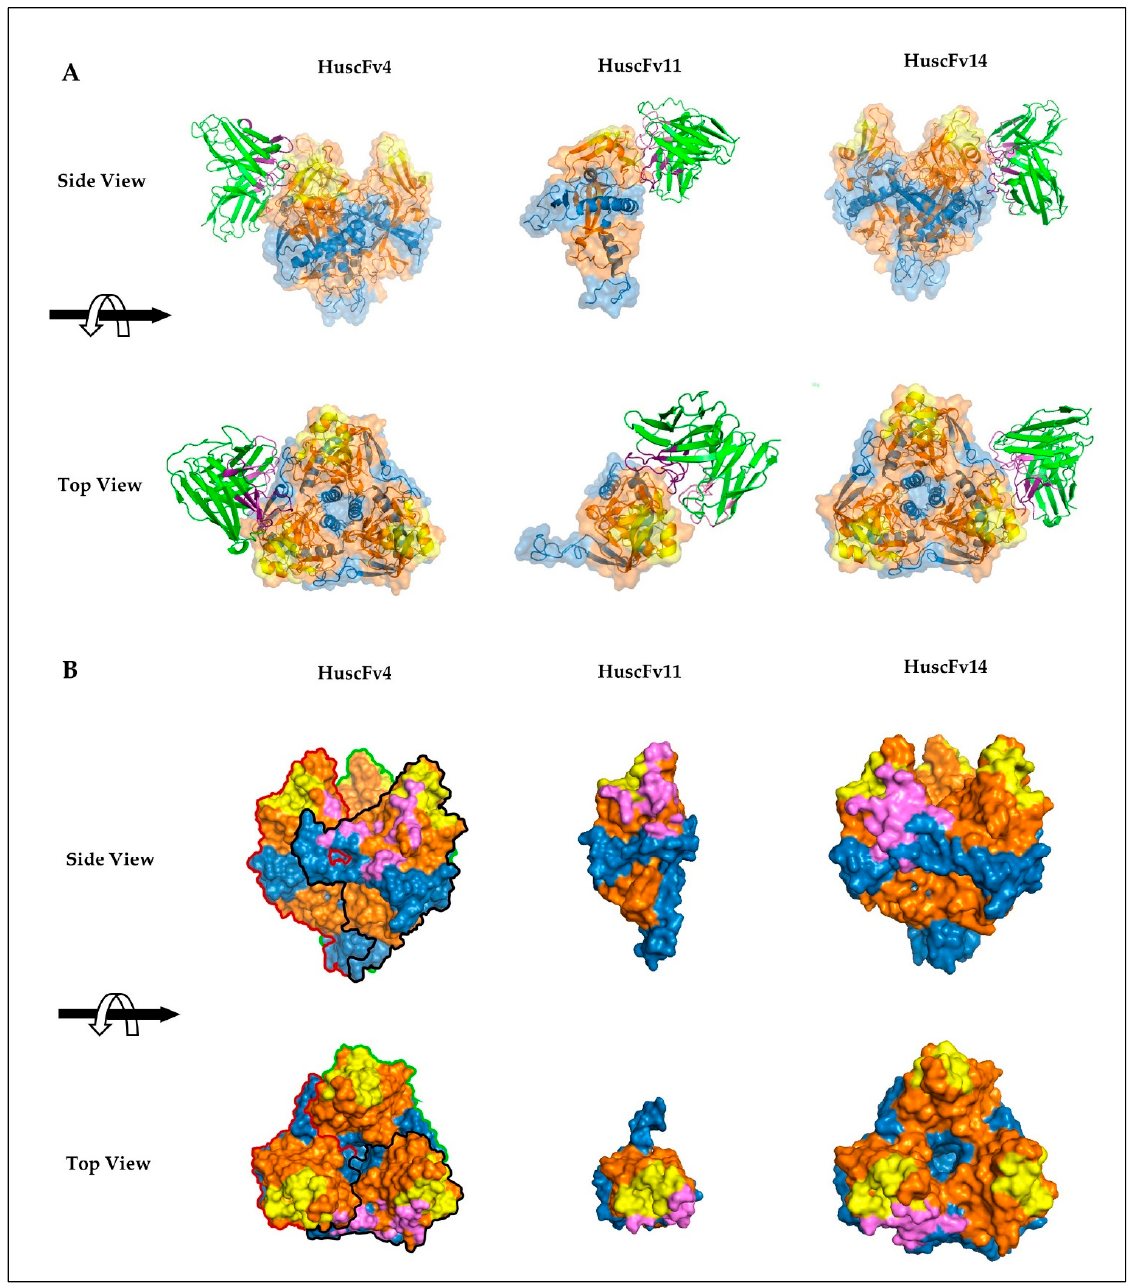
Figure 5. Presumptive binding of HuscFvs to GPcl predicted by computerized homology modeling and intermolecular docking. ( A ) Interactions of HuscFv4 and HuscFv14 to trimeric GPcl (PDB: 5F1B) (left and right panels, respectively) and HuscFv11 to monomeric GPcl (PDB: 5HJ3) (middle panel). The HuscFv-GPcl complexes are shown as the side view (upper panel) or top view (lower panel). The HuscFvs are colored in green, in which CDRH and CDRL loops are colored as dark and light purple, respectively. GP1, GP2, and RBS of the GPcl are in orange, blue, and yellow, respectively. (B ) Footprints in HuscFv-GPcl complexes as described in ( A ). Contact surface areas between the HuscFvs and the GPcl are colored in purple. The GP1, GP2, and RBS of each GPcl protomer are colored as described in ( A ). Solid black, red, and green lines indicate boundaries of individual GPcl protomers.